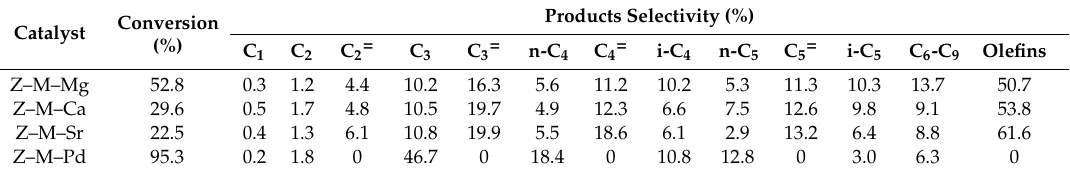
Table 6. The conversion of the catalytic cracking of n-decane and the products distribution a .